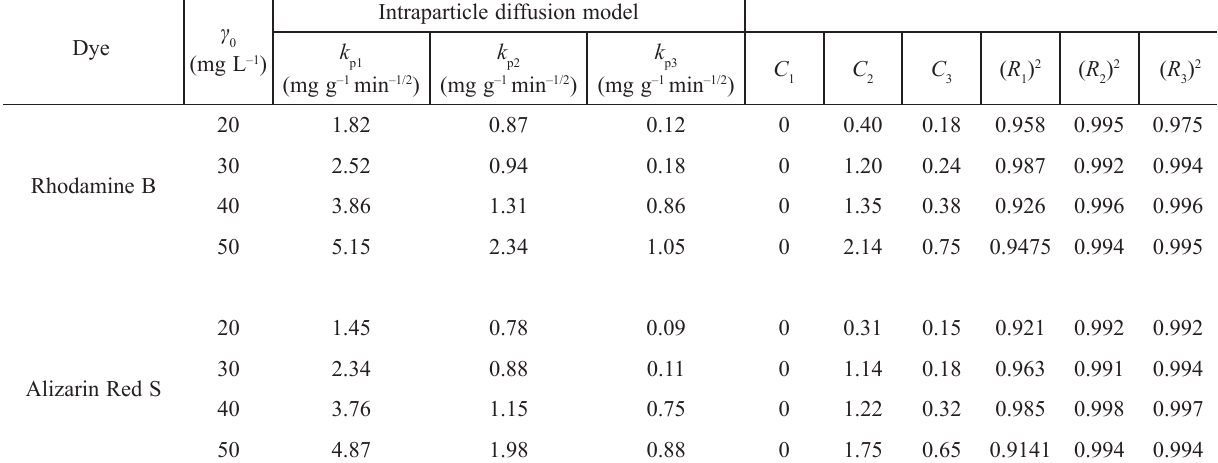
Table 4 – Data of intraparticle diffusion model for the adsorption of dye onto CES adsorbent